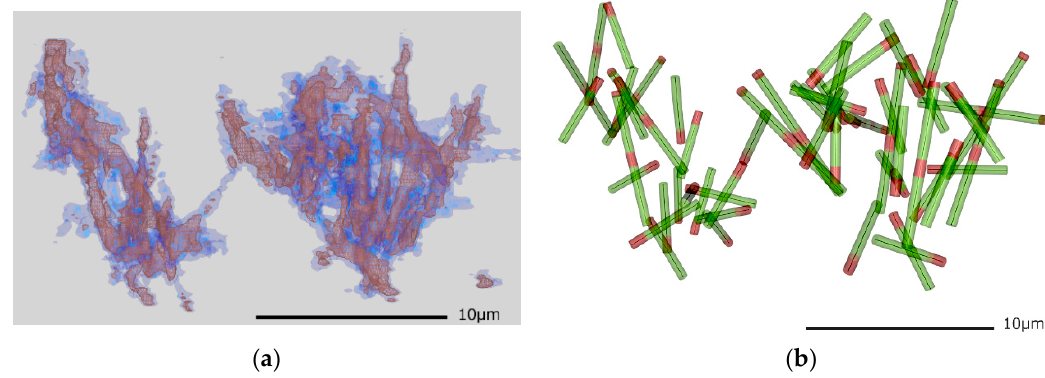
Figure 4. ( a ) The surface representation for obtained 3D volume data by z-slice images. Two isosurface values at high density (brown) and low density (blue) are depicted. Some portions of the blurred volumes showed less intensity. ( b ) Cylinder models of microtubules fitted to the observed volume data. We also tried to fit the direction of the cylinders, with one end marked in red, to the observation shown in Figure 3. Most network structures were well described by these cylinders, however, at regions where the cylinders intersect, it was difficult to recognize their geometrical components. The center lines for each cylinder are also depicted to indicate the real microtubule filament diameter of 25 nm. This inflation of the cylinder radius due to the resolution limit is discussed in Section 4.1.